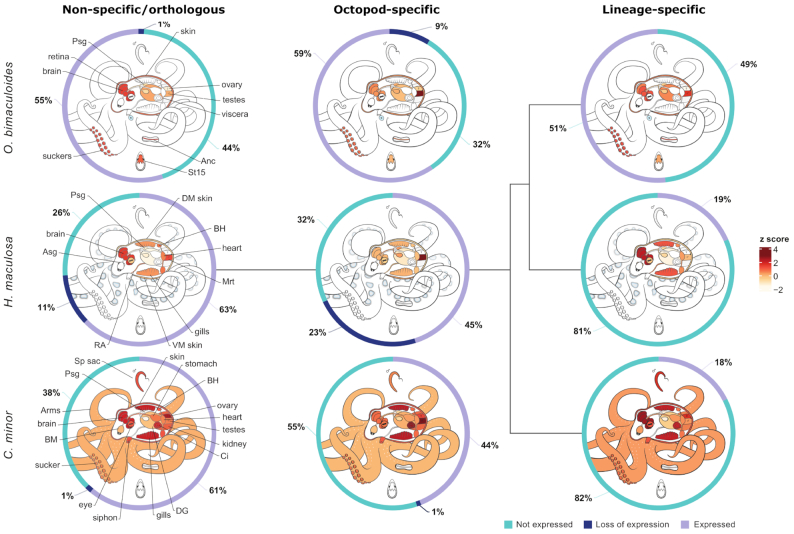
Dynamics of gene expression in octopod genomes. Proportion of gene expression across levels of specificity from not specific to octopods or an octopus species (left) to octopod-specific (middle) and lineage-specific (right). Donut plots show gene expression as some expression in any tissue (purple), no expression (blue), or expression that has been lost (dark blue). Loss of expression requires an ortholog of the gene to be expressed in ≥1 species and not expressed in the other species. Heatmaps at each specificity level show average expression of genes within their respective tissues, low expression (cream) to high expression (dark red).